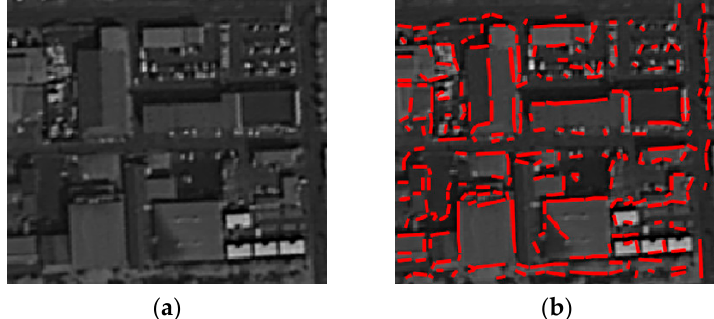
Figure 3. ( a ) Original very high-resolution (VHR) panchromatic (Pan) image; and ( b ) Lines extracted by the regular grid-based Hough transform (RGHT) (red lines).